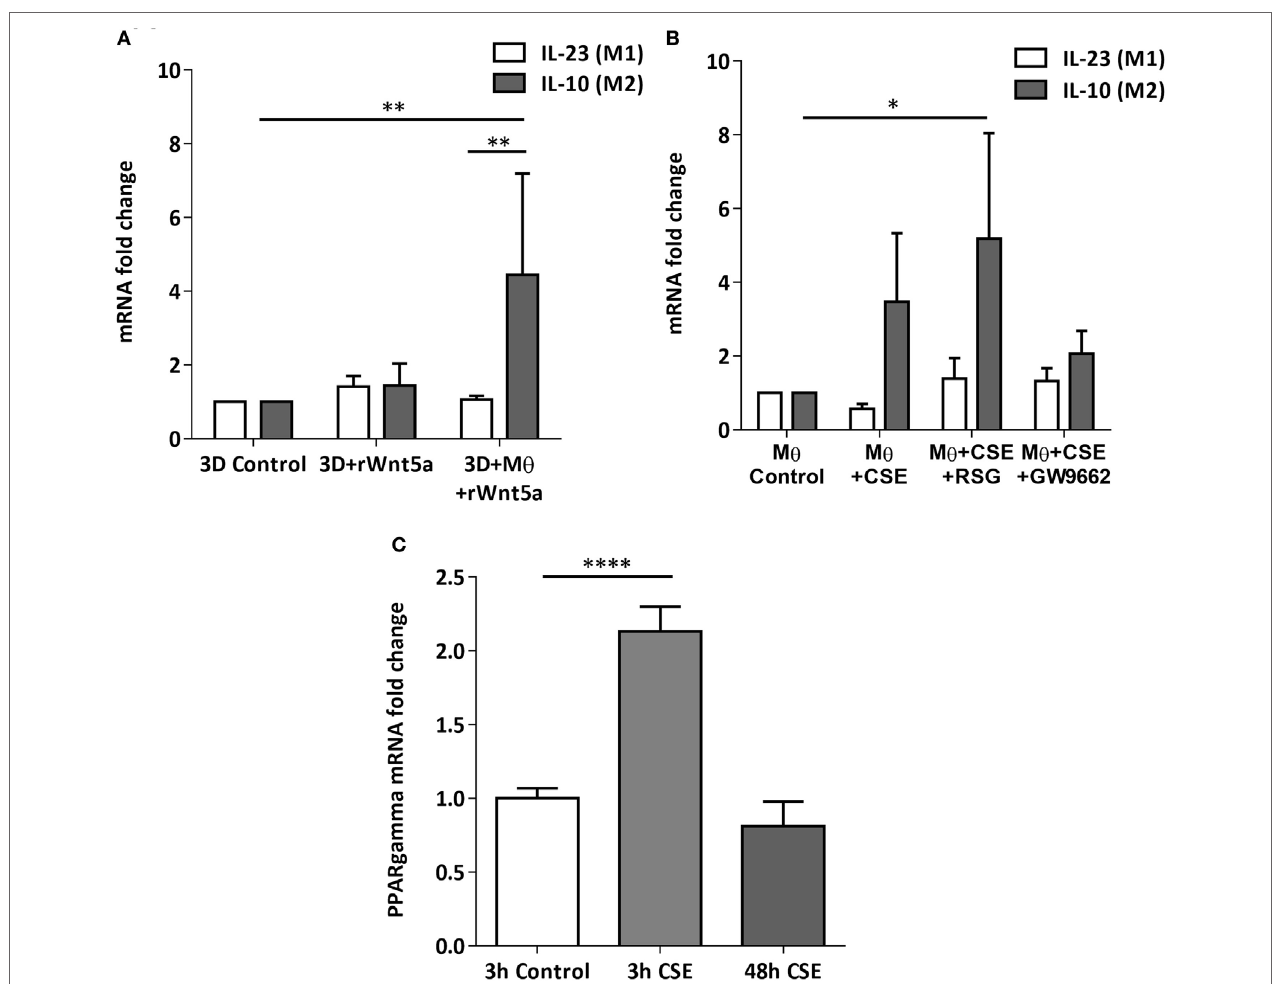
FigUre 4 | Changes of peroxisome proliferator-activated receptor (PPAR) gamma mRNA levels in M1 and M2 M type differentiation in primary human 3D lung aggregate cultures and M monocultures. (a) qRT-PCR analysis of M1 (differentiation marker IL-23) and M2 (differentiation marker IL-10) after human rWnt5a (1 µg/ml) treatment for 48 h. (B) Effects of cigarette smoke extracts (CSE), PPAR gamma agonist (RSG), and antagonist (GW9662) treatment on expression of M1 (IL-23) and M2 (IL-10) differentiation markers. CSE treatment (48 h) and also CSE + RSG (10 µM) and CSE + GW9662 (10 µM) treatment on human M. (c) PPAR gamma mRNA levels in CSE treated human macrophage cultures after 3 and 48 h of CSE treatment compared with